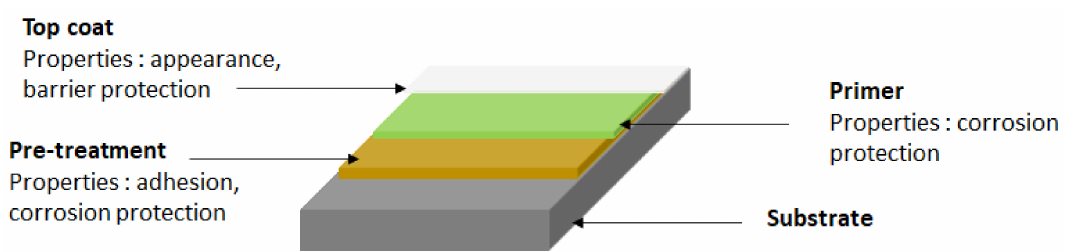
Figure 4. Schematic illustration of a coating system for corrosion protection in aircraft structures.